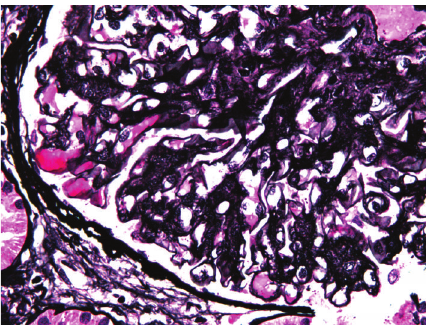
Figure 2: Hematoxylin-eosin stain ( × 400) shows accumulation of amorphous acidophilic extracellular material in mesangium and capillary walls.